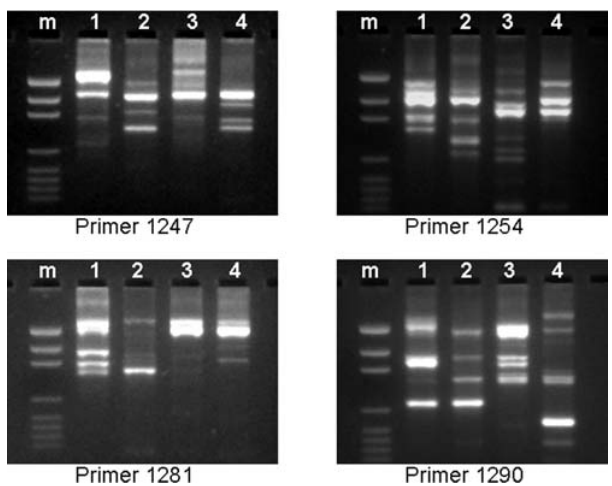
Figure 1. DNA fingerprinting (RAPD) of four H.pylori strains: USU101, isolated from an Albanian patient with gastric adenocarcinoma (1), USU102, isolated from a U.S. Caucasian patient with no ulcer (2), strain J99 (3), and strain 26695 (4). Note that the DNA fingerprints of the four strains are quite different from each